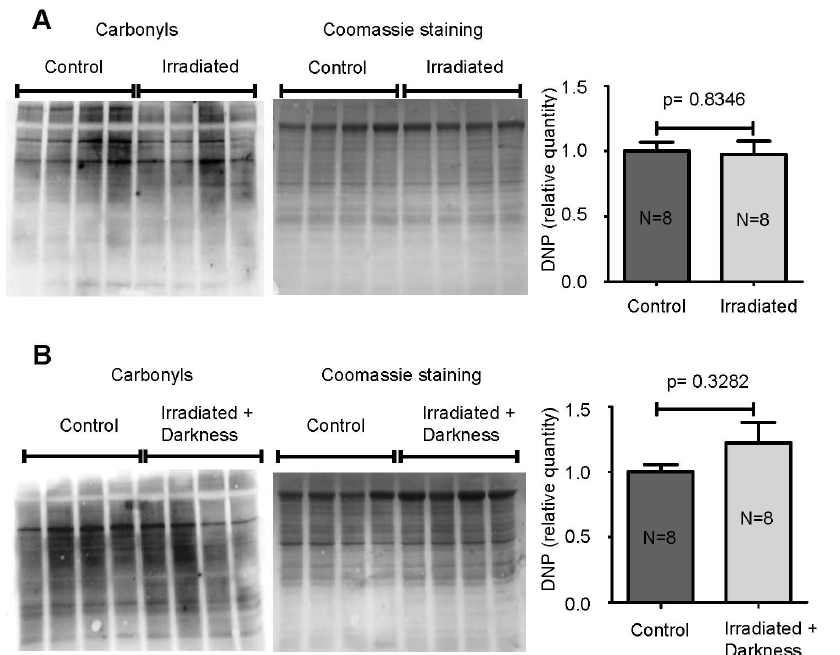
Figure 5. Protein oxidation evaluated by measuring the carbonylation of amino acid side chains. Representative oxiblots of carbonylated proteins from larvae submitted to space radiation ( A ) or larvae that developed in the dark and under the simulation of ISS radiation ( B ) are shown. Each lane contains proteins from 3 larvae. Equal protein loading was assessed by Coomassie staining. Western blot results were analyzed and quantified by densitometry using a Fusion Fx7 imaging system (Vilber Lourmat, Marne-la-Valle´e, France) and carbonylation was normalized to the total amount of protein. Results are expressed as the mean 6 SEM.